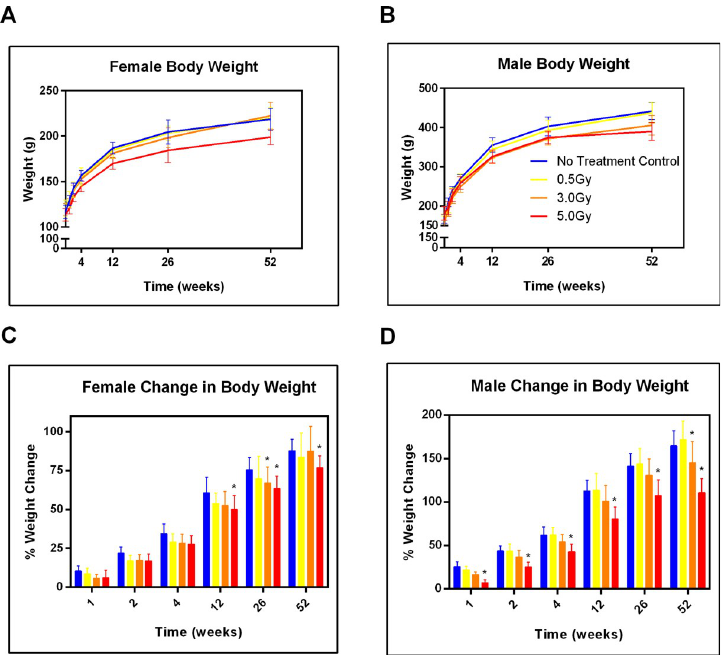
Fig 1. Total body irradiation negatively impacts growth for up to one year. The average female (A) and male (B) body weight is displayed over one year. The average change in female (C) and male (D) body weight is displayed over one year. From left to right, groups of bars denote no treatment control, 0.5Gy, 3.0Gy, and 5.0Gy for each timepoint. Error bars represent standard deviation. NT = no treatment; � p < 0.05 wrt NT, two-way ANOVA with Dunnett’s test to correct for multiple comparisons; n =